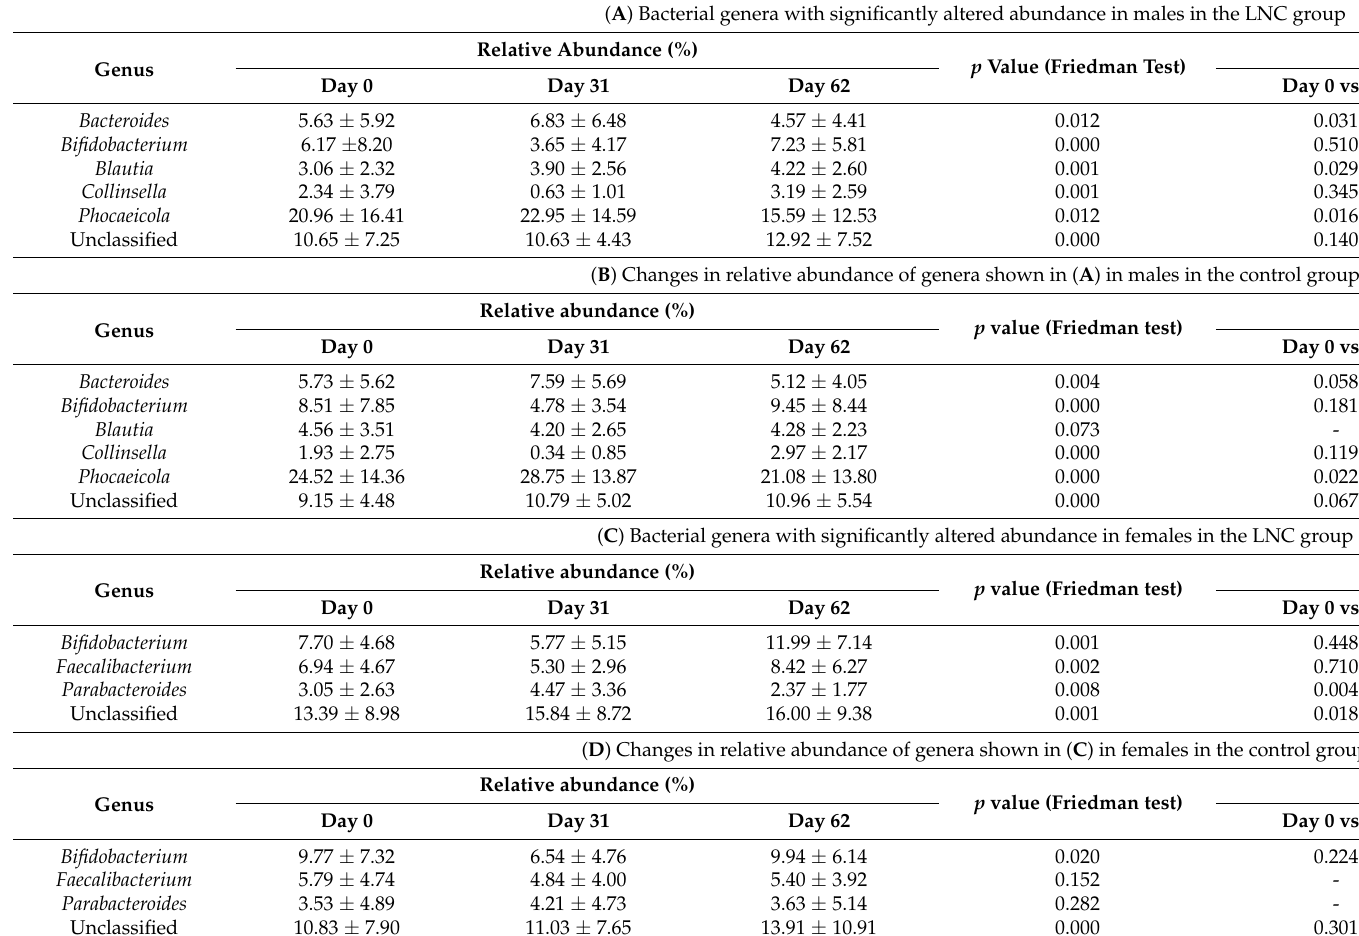
Table 2. Changes in the relative abundance of each